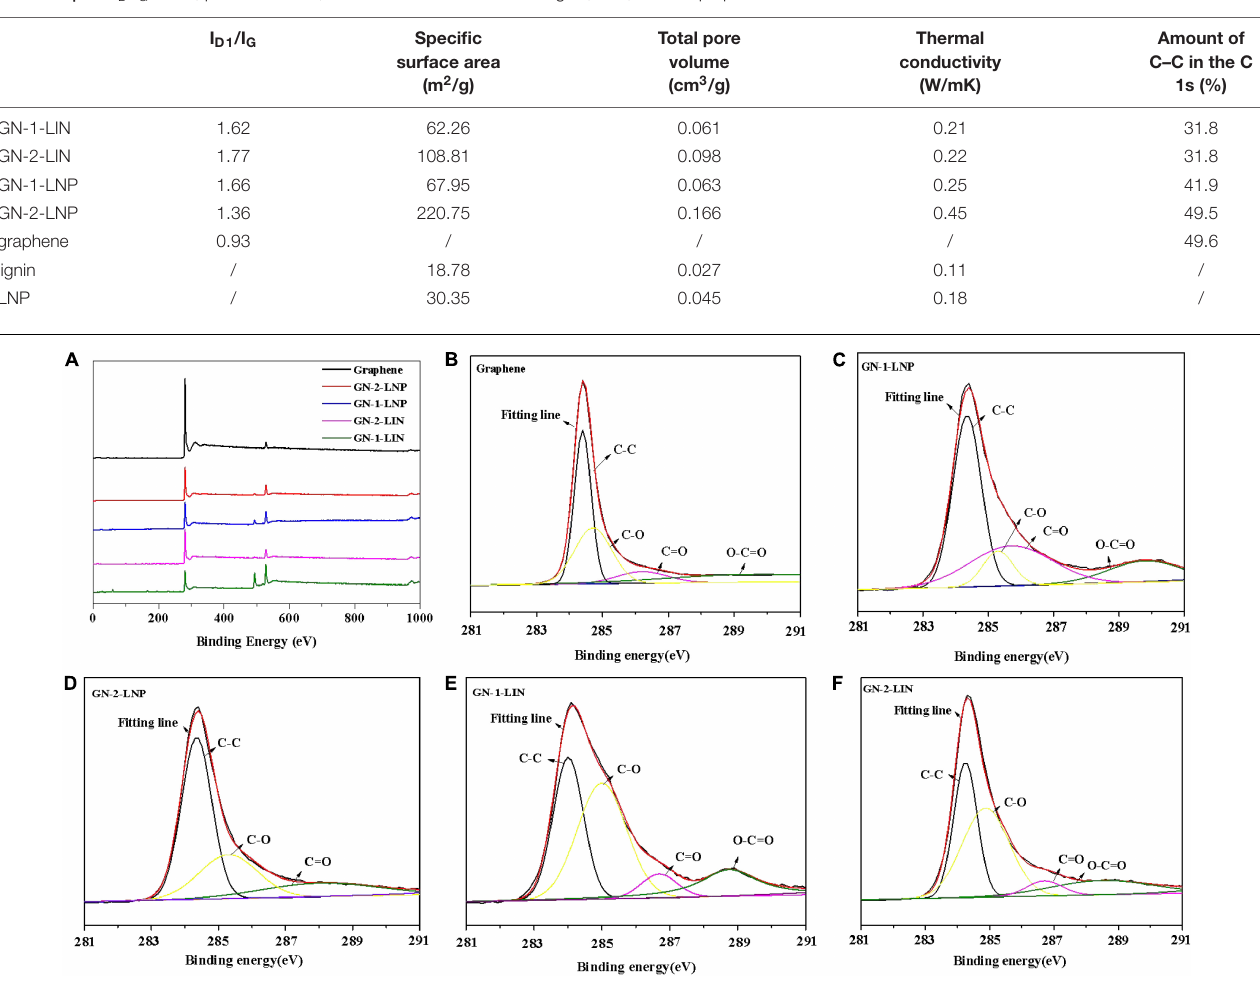
FIGURE 6 | XPS spectra of the prepared carbons and commercial graphene (A) , deconvoluted C 1s spectra of commercial graphene (B) , GN-1-LNP (C) , GN-2-LNP (D) , GN-1-LIN (E) , and GN-2-LIN (F) .